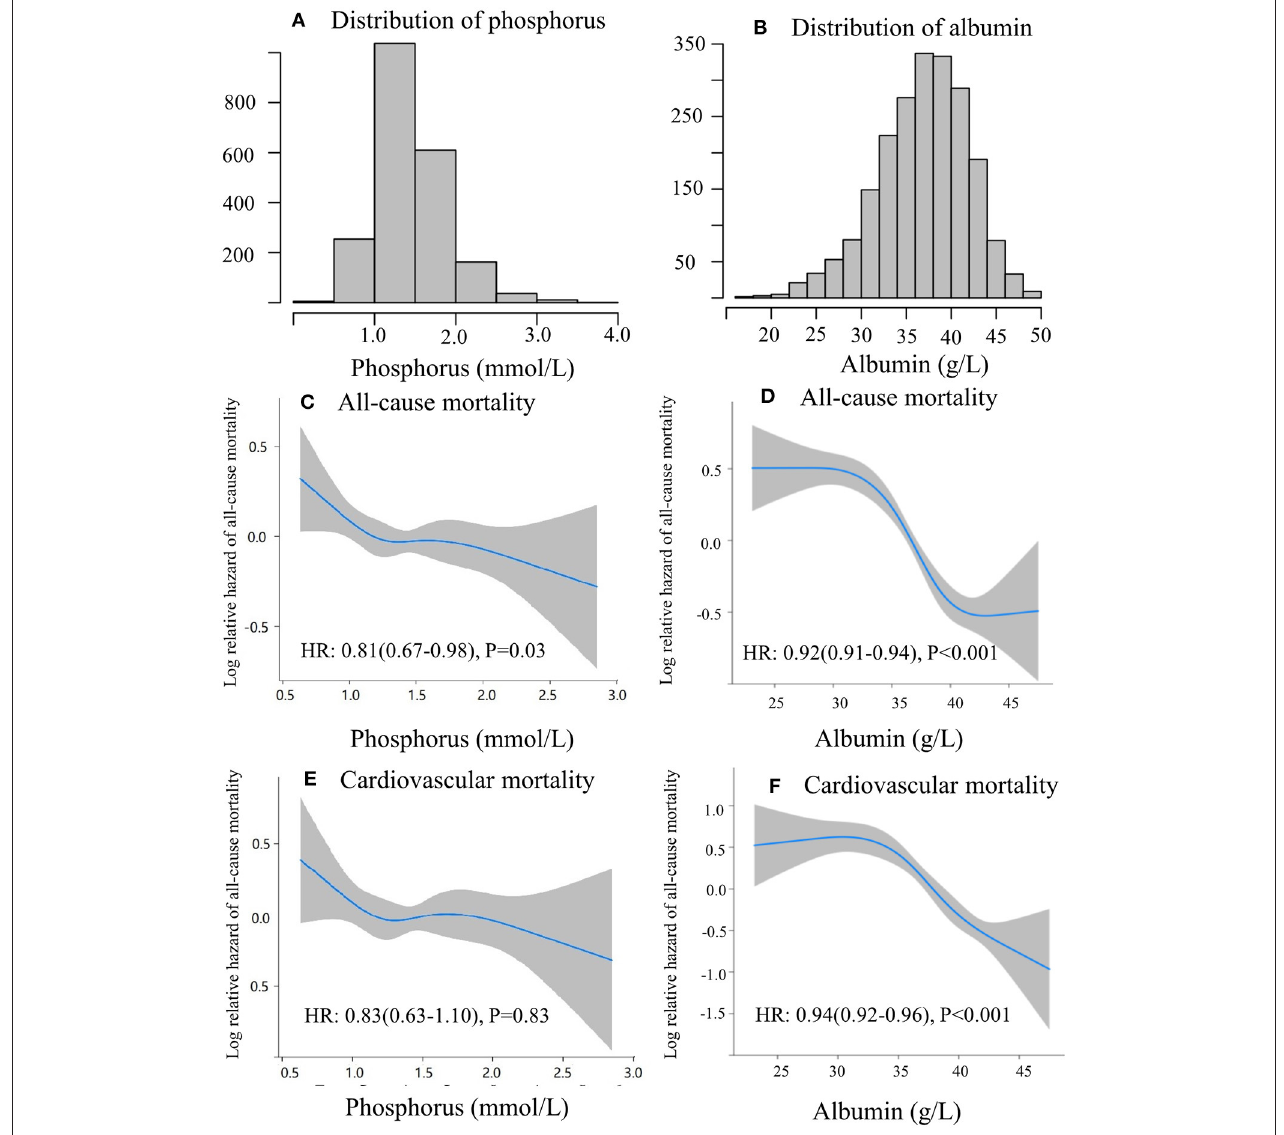
FIGURE 2 | Linear and non-linear correlation between serum phosphorus and albumin with mortality. The distribution of serum phosphorus (A) , and albumin (B) . Restricted cubic spline of phosphorus (C) , albumin (D) and all-cause mortality; restricted cubic spline of phosphorus (E) , albumin (F) , and cardiovascular mortality.